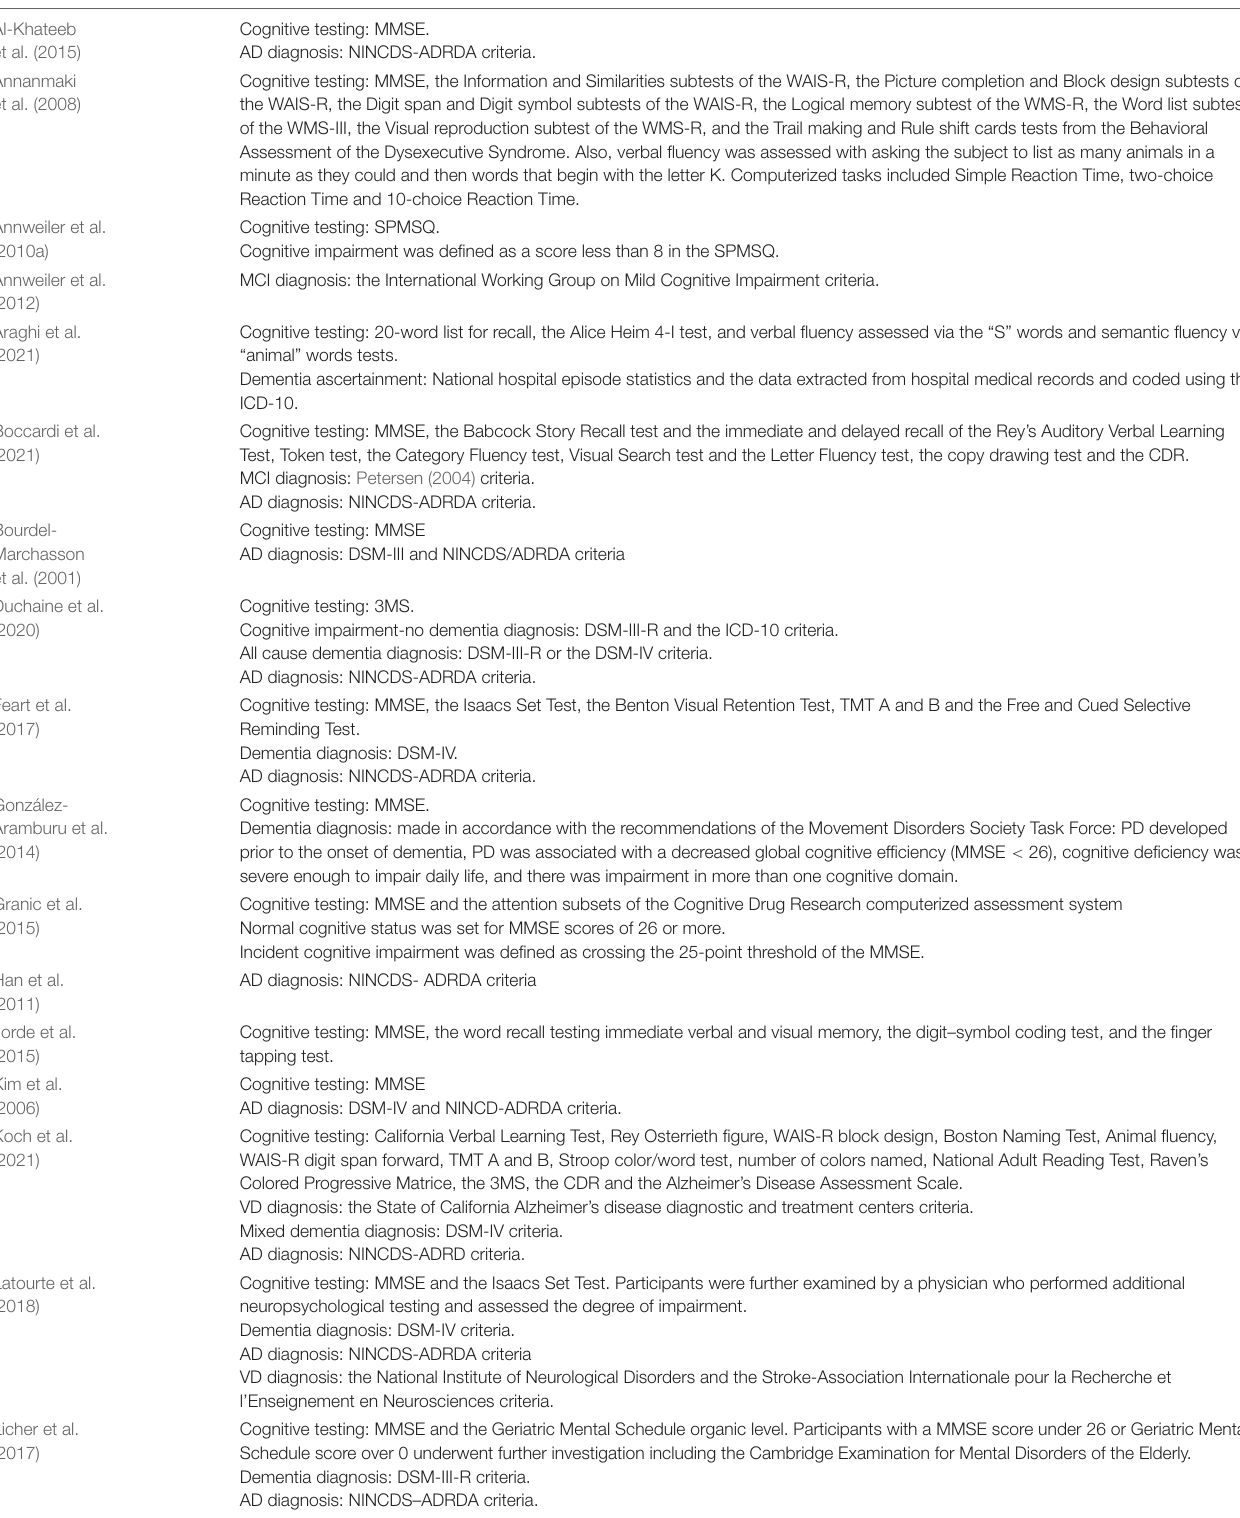
TABLE 5 | Cognitive assessment or diagnostic criteria applied by the studies included in the discussion